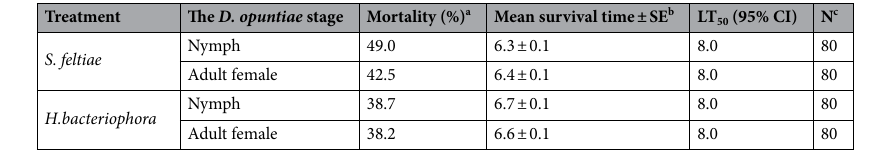
Table 4. Mortality (%), mean survival time, and LT 50 (days) of Dactylopius opuntiae -treated nematode isolates with concentration 25 IJs cm −2 . a Abbott-corrected percentage mortality of D. opuntiae nymphs and adults female at the end of experiment. b The mean survival time and its standard error. c Total number of D. opuntiae in bioassay.